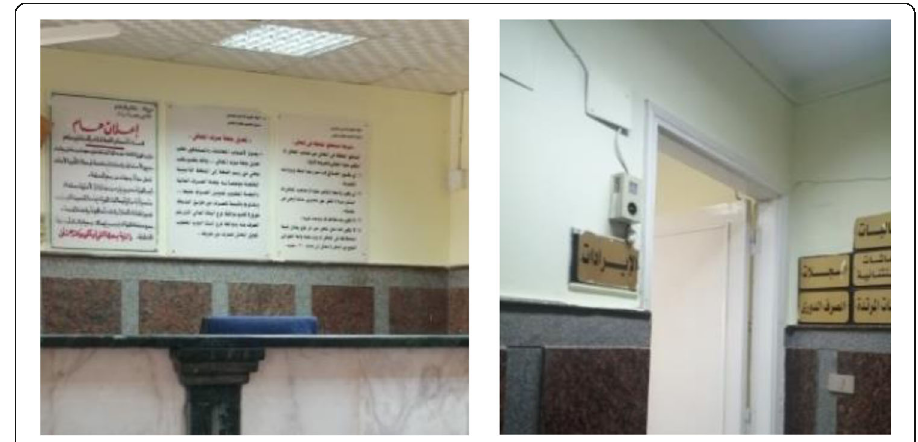
Fig. 18 Signs of required administrative papers and room ’ s labels.